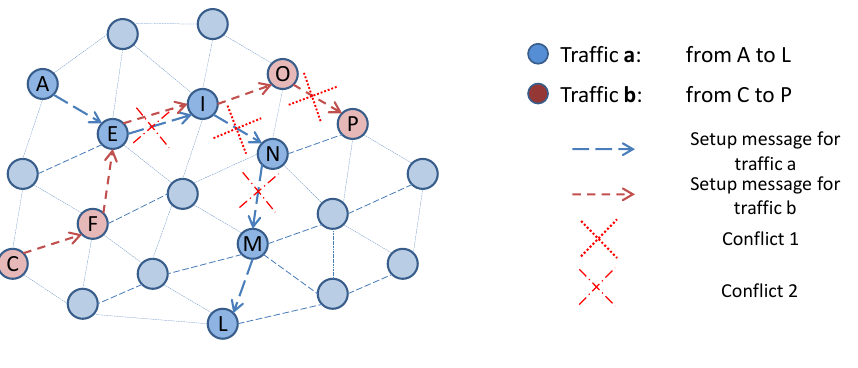
Figure 16. Resource reservation conflict sample.